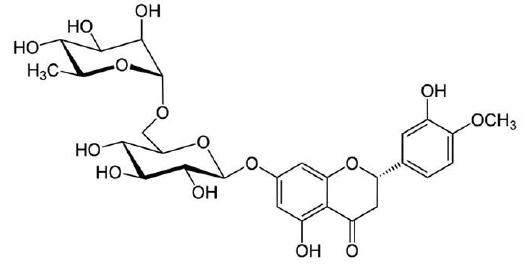
Figure 6. Molecular structure of